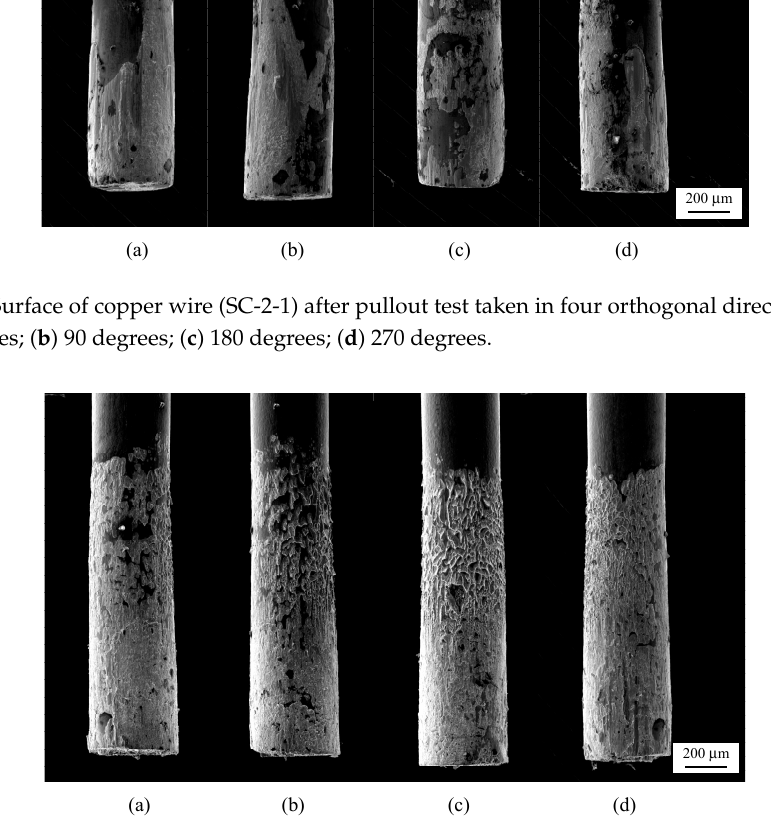
Figure 7. Surface of copper wire (SC-0.5-3) after pullout test taken in four orthogonal directions: ( a ) 0 degrees; ( b ) 90 degrees; ( c ) 180 degrees; ( d ) 270 degrees.